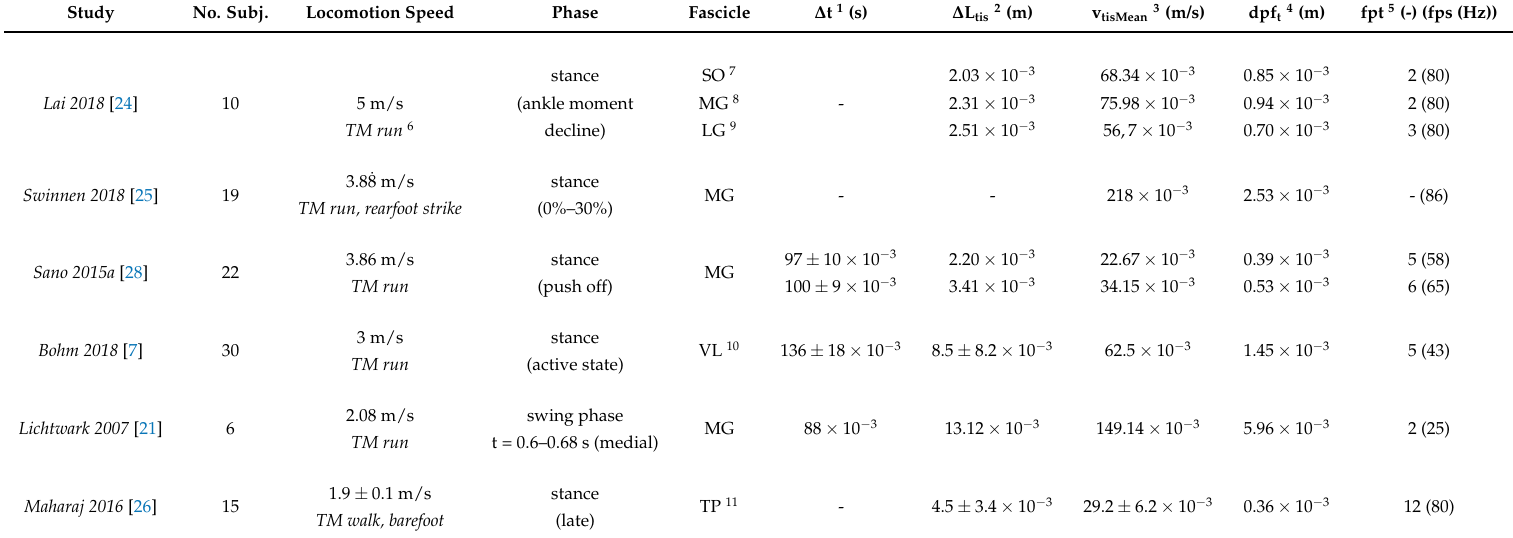
Table 3. Mean fascicle velocities and mean calculated frame-rate-dependent parameters for critical time intervals in the gait cycle where maximum tissue velocities occurred. Note that not all studies examined provided sufficient information (e.g., only statistical values) to extract all parameters for the investigated time intervals. Study No. Subj.